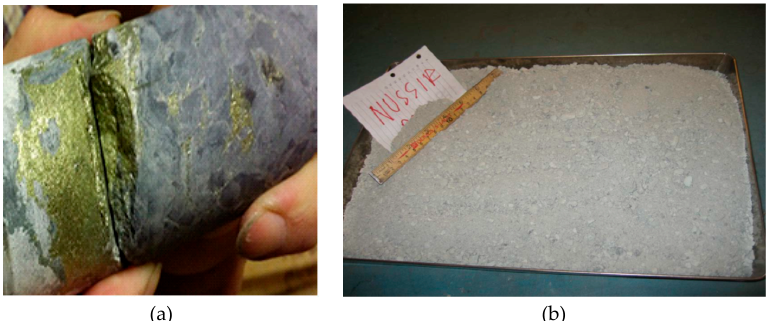
Figure 1. ( a ) The Nussir drill hole specimen: Veinlets of chalcocite and bornite on a carbonate structure; ( b ) the crushed ore sample received from Nussir ASA.